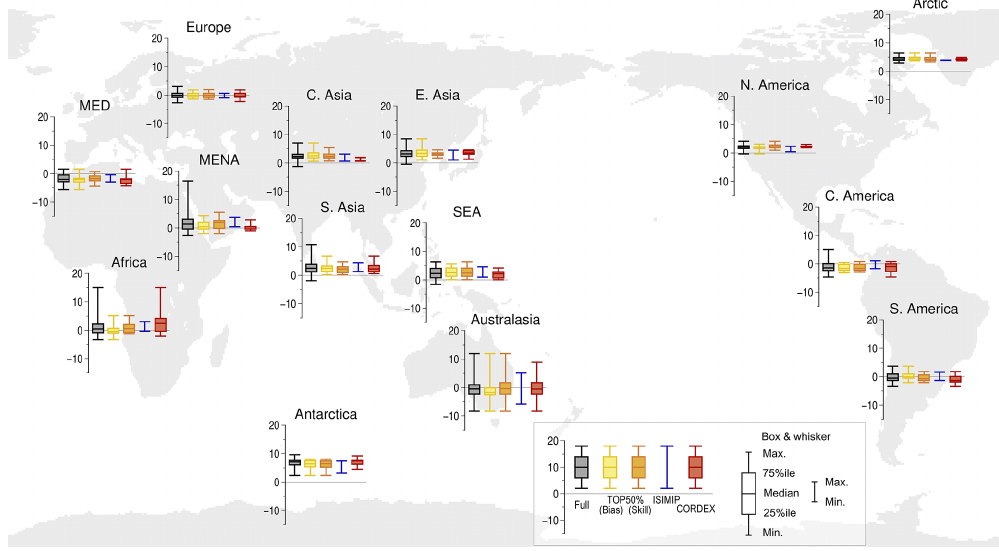
Figure 3. As for Fig. 2, but for the projected change in annual mean precipitation scaled to the regional mean temperature increment over land (%K − 1